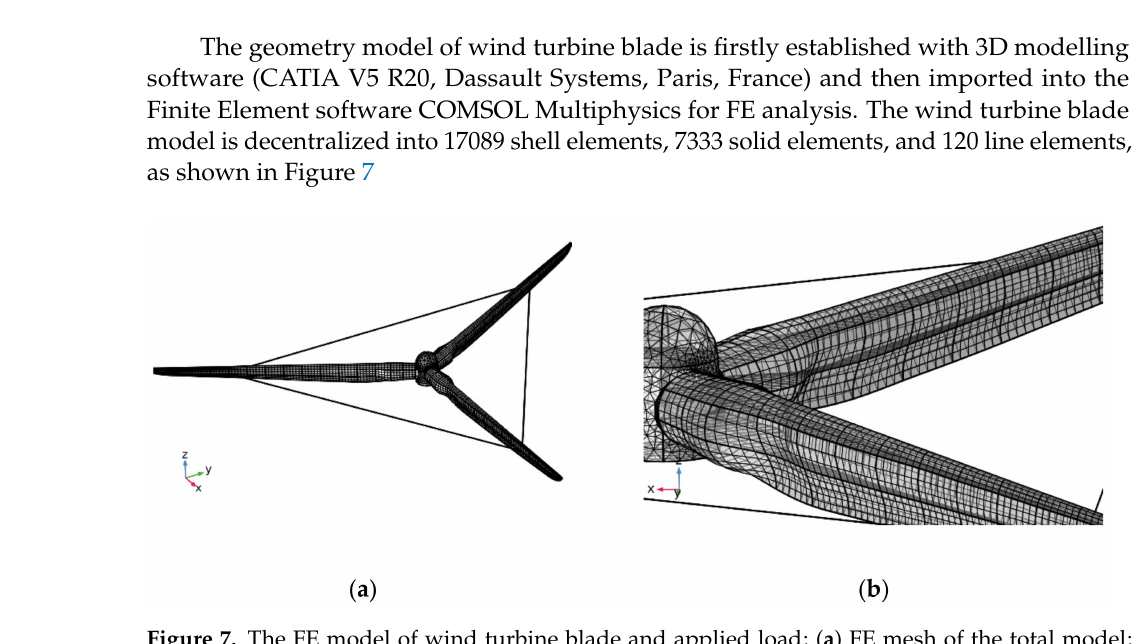
Figure 7. The FE model of wind turbine blade and applied load; ( a ) FE mesh of the total model; ( b ) Local enlarged view of FE mesh.